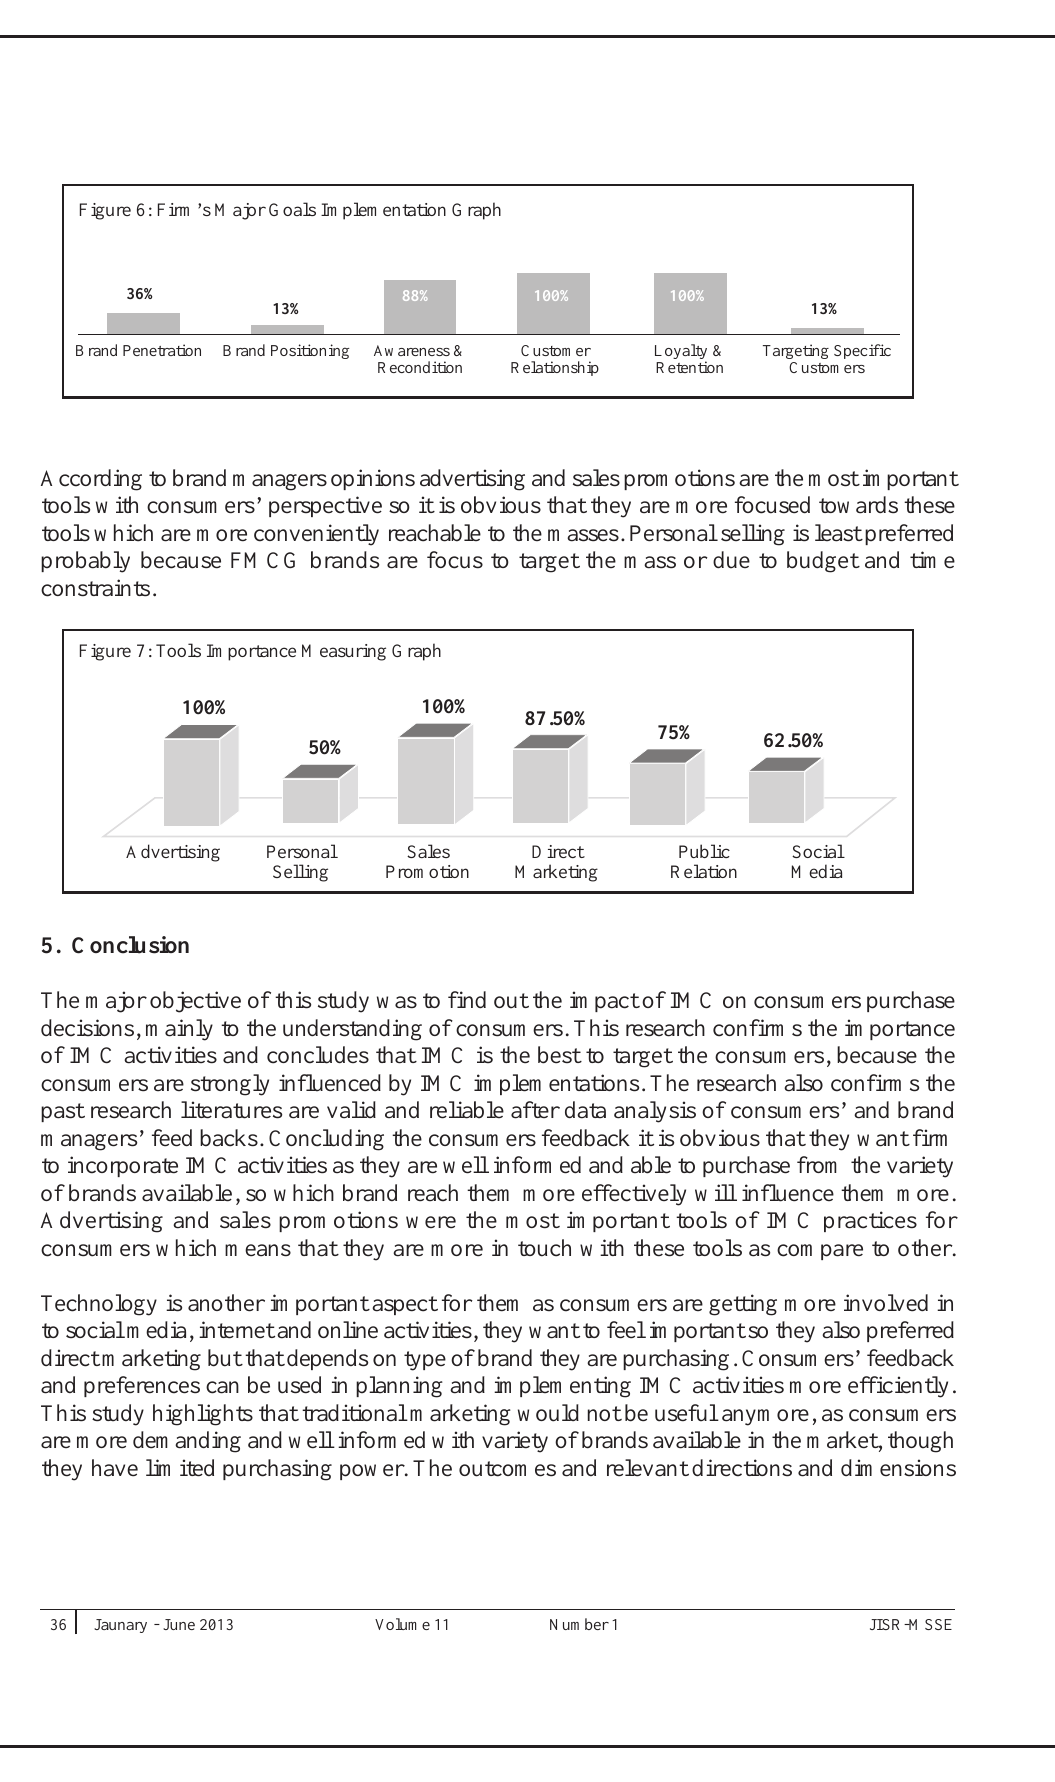
Customer Relationship